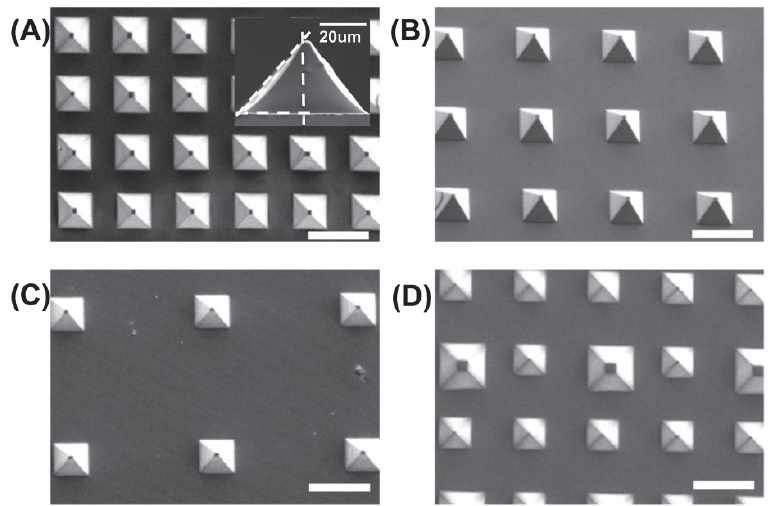
Figure 5. Pyramidal patterns on PDMS layer transferred from the silicon mold (scale bars are 100 µ m). ( A ) Spacing of 41 µ m, ( B ) 88 µ m, ( C ) 182 µ m and ( D ) interspersed design of two pyramidal structures with different based area. The inset in the upper left image shows the cross-section of a pyramidal structure. Reproduced with permission from [66], Copyright (2014), Wiley-VCH.